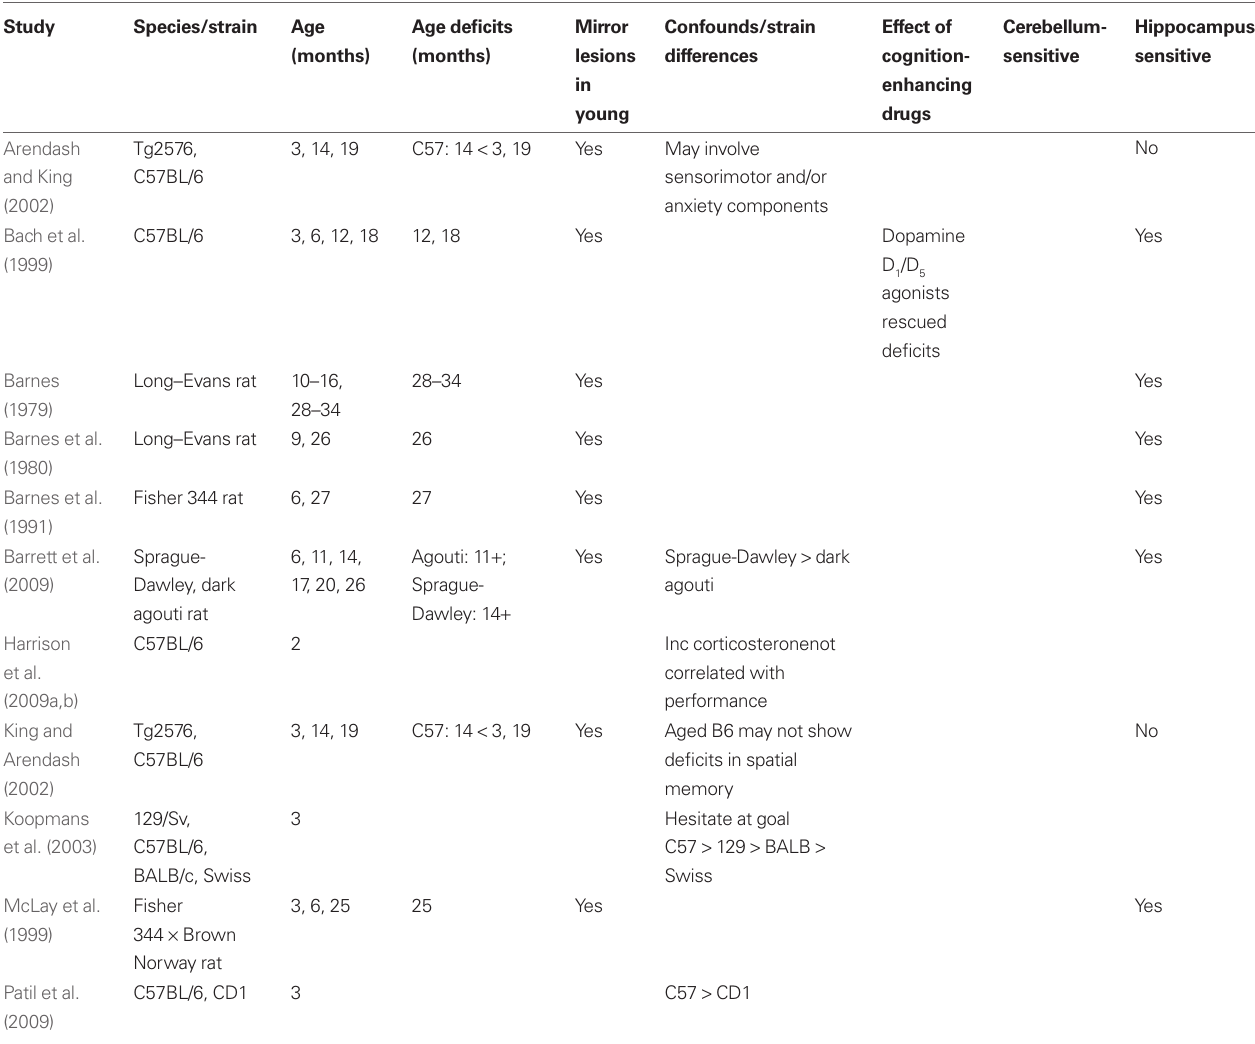
Table 2 | Barnes maze: age